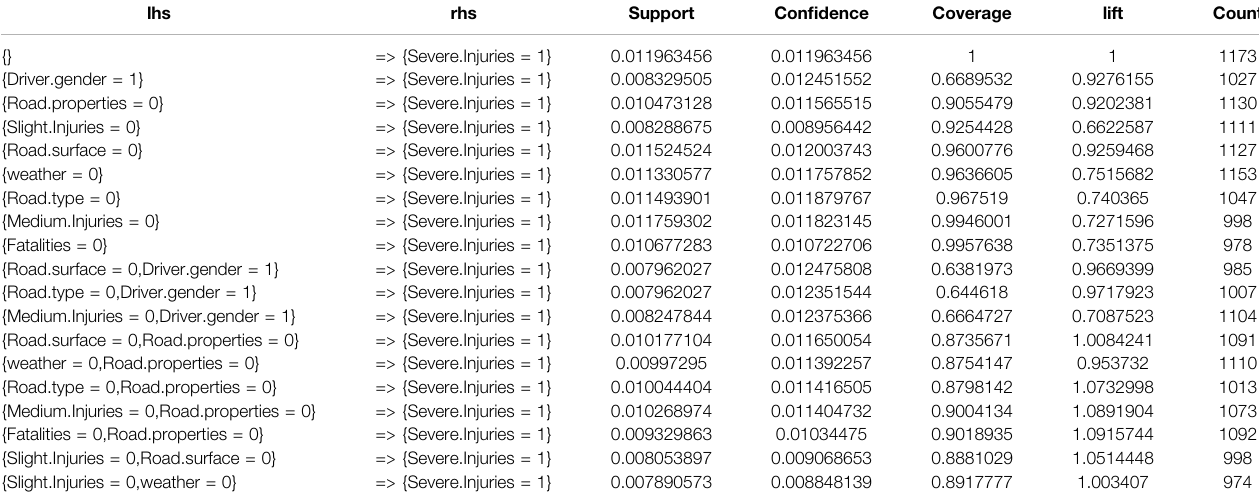
TABLE 6 | Severe injury results.